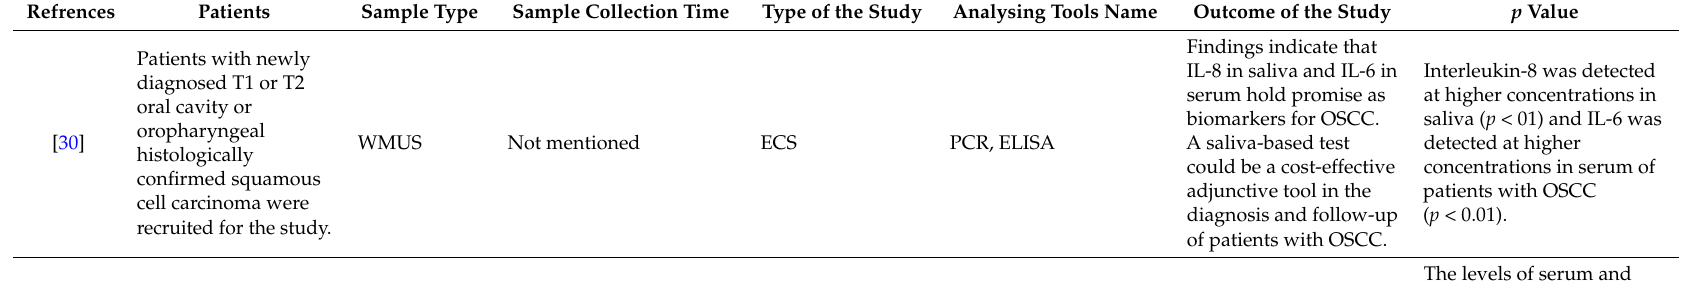
Table 1. Description of reported studies on salivary IL-8 as an oral cancer